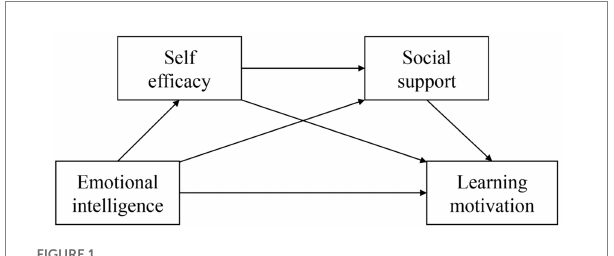
FIGURE 1 Research hypothesis framework